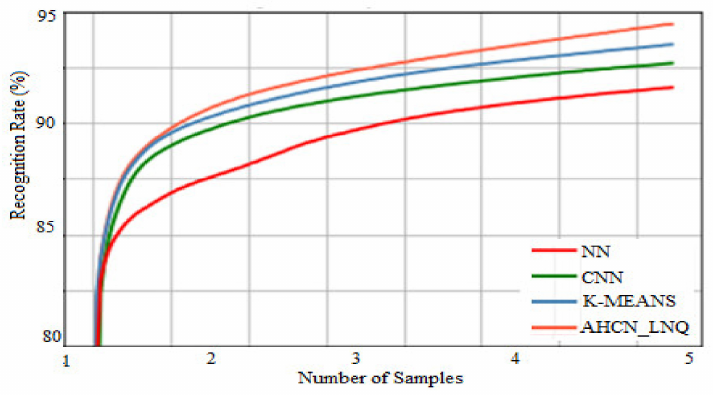
Figure 8. Accuracy of training